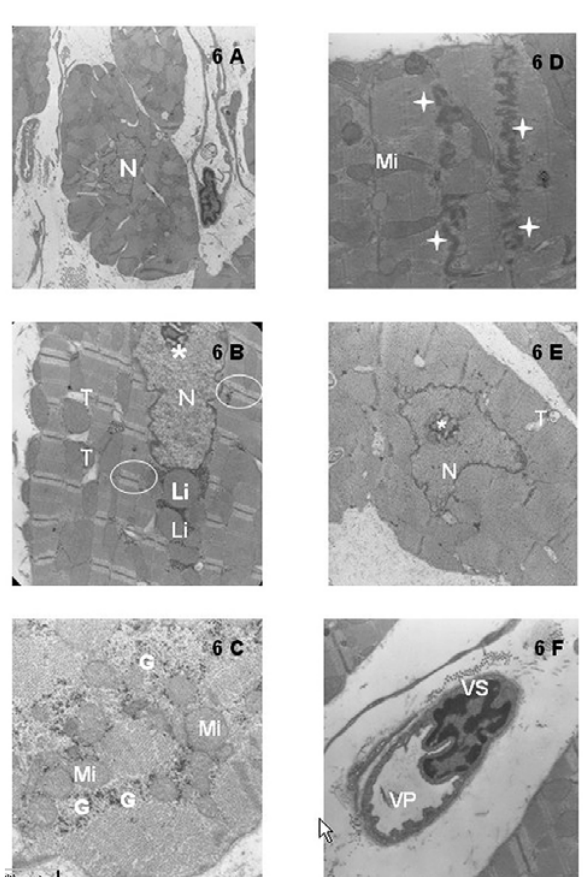
Fig. 6 - Eletromicrografias do miocárdio do grupo experimental I:corações hipertrofiados submetidos à parada com cardioplegia sangüínea contínua e tépida (grupo experimental I). Discos intercalares preservados (estrela), aumento da área nucleolar (*), núcleos com descondensação cromatínica (N), mitocôndrias com cristas evidentes (Mi), abundância de glicogênio (G), acúmulo de lipídio no citoplasma dos cardiomiócitos (Li), túbulos T ligeiramente dilatados (T), aparente estado de contração miocárdica (círculo) e vasos sangüíneos (VS) com grande quantidade de vesícula de pinocitose (VP). A: 6A = 7750x; 6B = 7750x, 6C = 10000x; 6D =